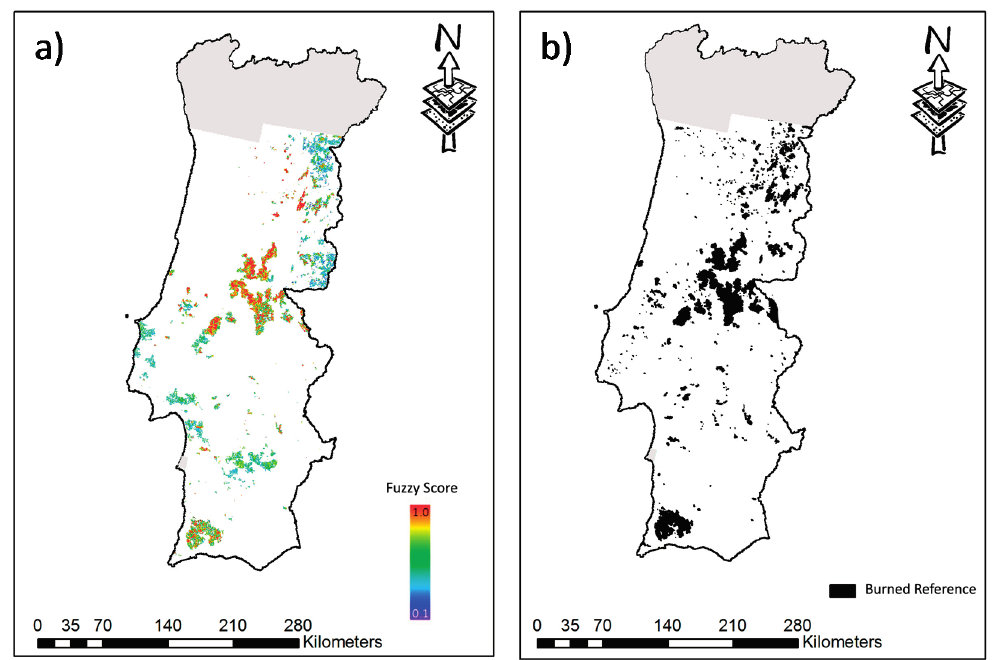
Figure 6. ( a ) The obtained fuzzy score map; ( b ) the reference map derived from the Landsat based Fire Atlas of Portugal (where black and white represent burned and unburned areas,